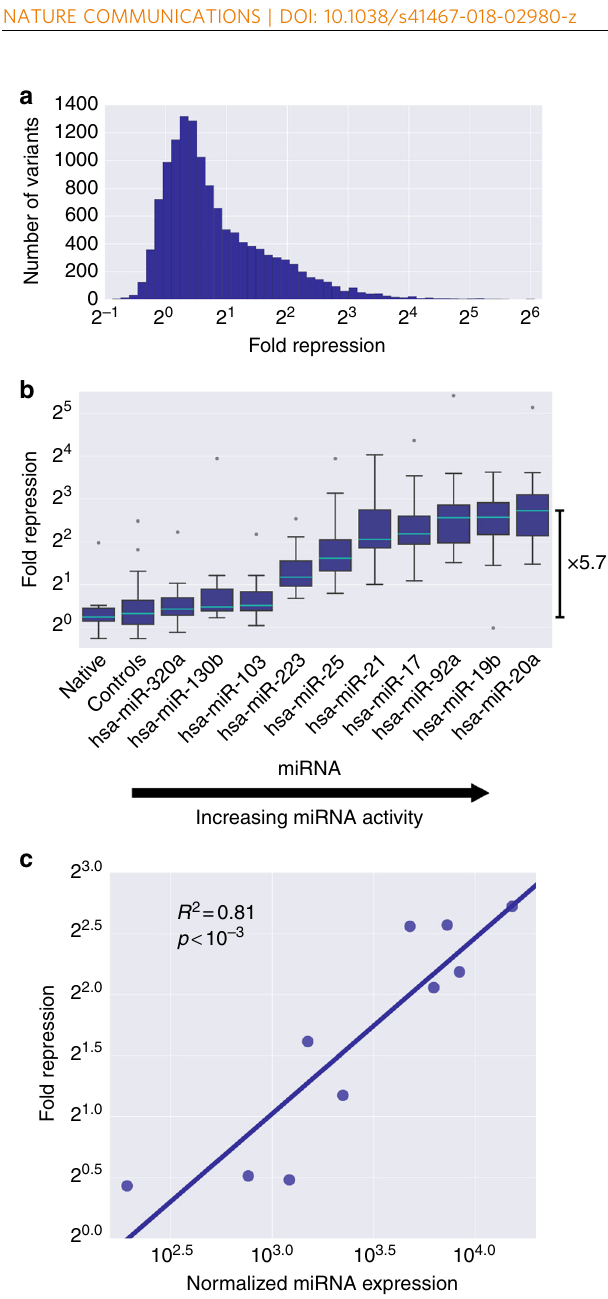
Fig. 2 The miRNA abundance is a major determinant of the highly skewed protein repression distribution. a A histogram depicting the distribution of protein repression levels acquired by the method described in Fig. 1d. b Comparison of protein repression levels as a function of different miRNA identities. Each boxplot contains up to 20 variants generated by placing MREs for our ten selected miRNAs, perfectly matched to their miRNAs, in ten varying contexts at two positions, by replacing the existing sequence with the miRNA target site. The resulting data reveal that the position of the binding site had no signi fi cant effect ( p = 0.96, Mann – Whitney U test). Therefore, we grouped the sequences by miRNA identity alone and examined its effect on repression. The bar depicts the 5.7-fold difference in median repression between hsa-miR-20a and the native contexts. c The median protein repression from b as a function of the miRNA expression levels, as quanti fi ed by a published microarray experiment 34 , for the ten selected miRNAs. Calculated R 2 and associated p -values